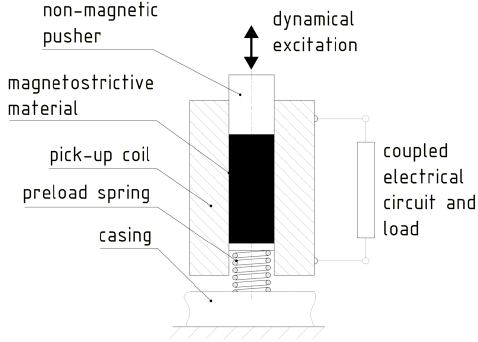
Figure 14. Typical magnetostrictive EH device.